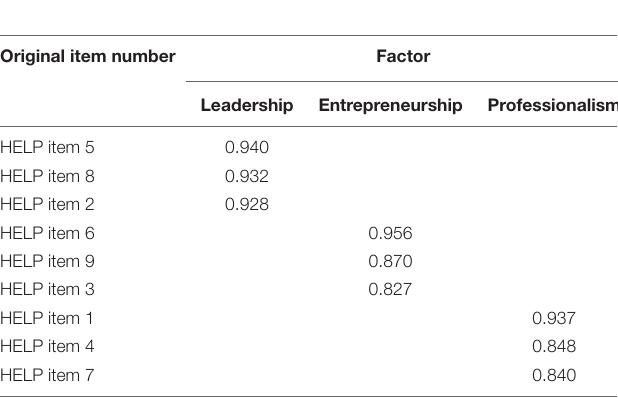
TABLE 1 | Exploratory factor analysis (EFA) results (principal axis factoring method, promax rotation).